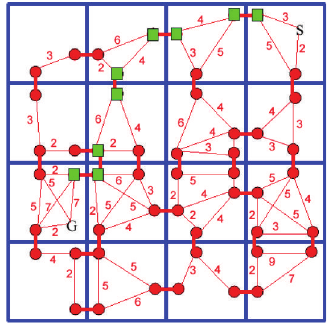
Figure 11: Use A ∗ to find path from S to G with cost 29.